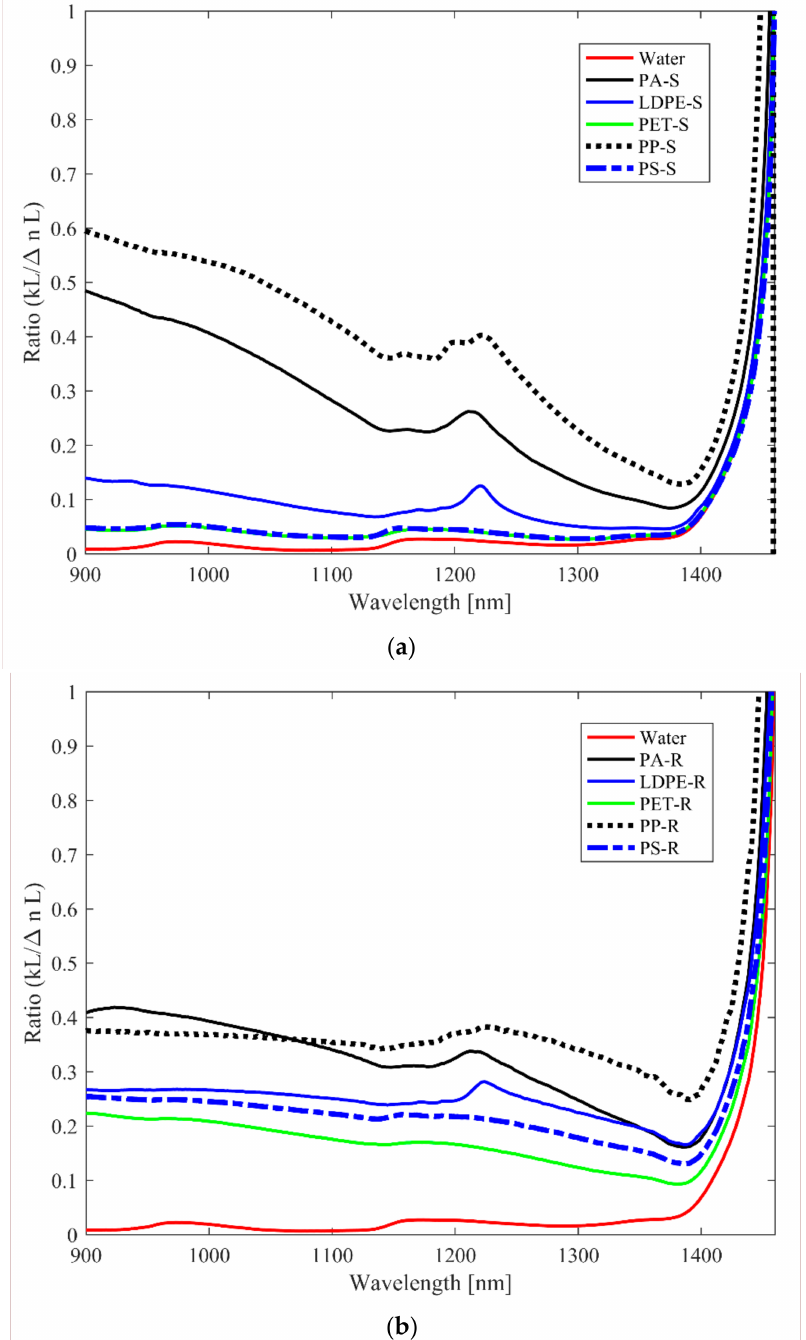
Figure 4. Ratio ( σ ) curves for macroplastics of the di ff erent plastic types ( a ) Smooth plastics; ( b ) Rough